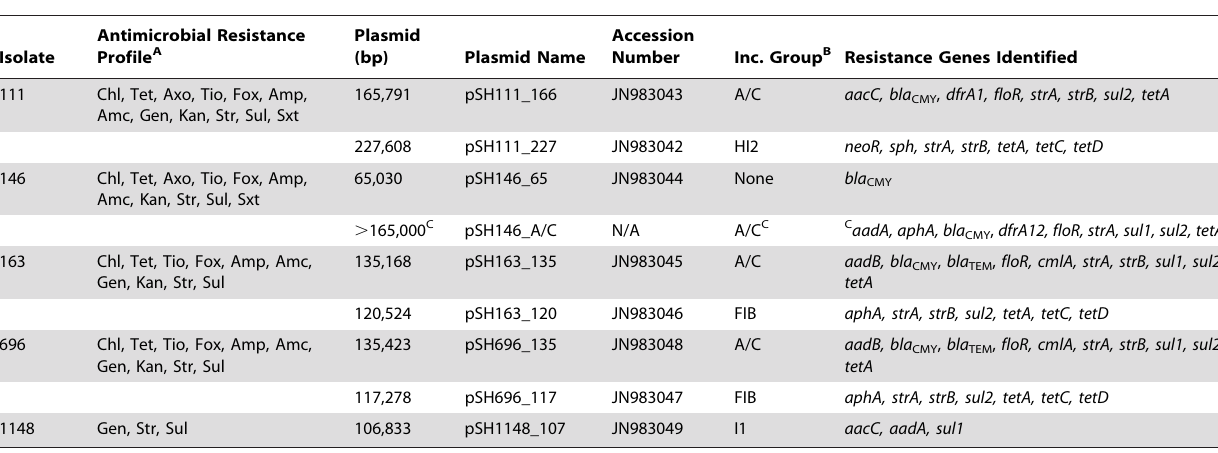
Table 1. Bacterial isolates used in this study and their characteristics.